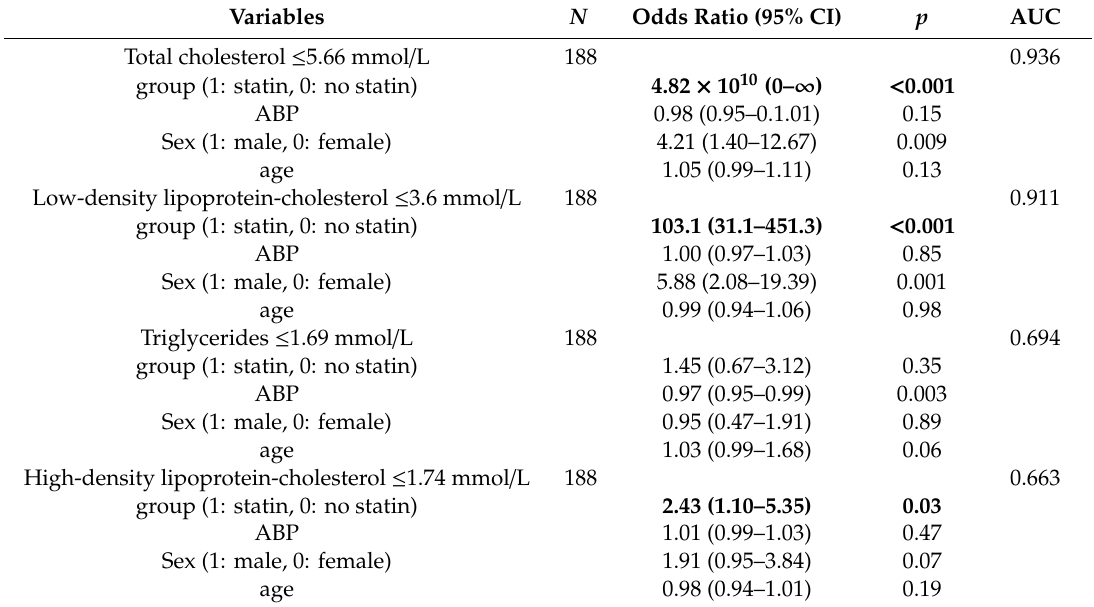
Table 3. Multiple logistic regression analysis for low lipids levels adjusted to age, sex. ABP, and